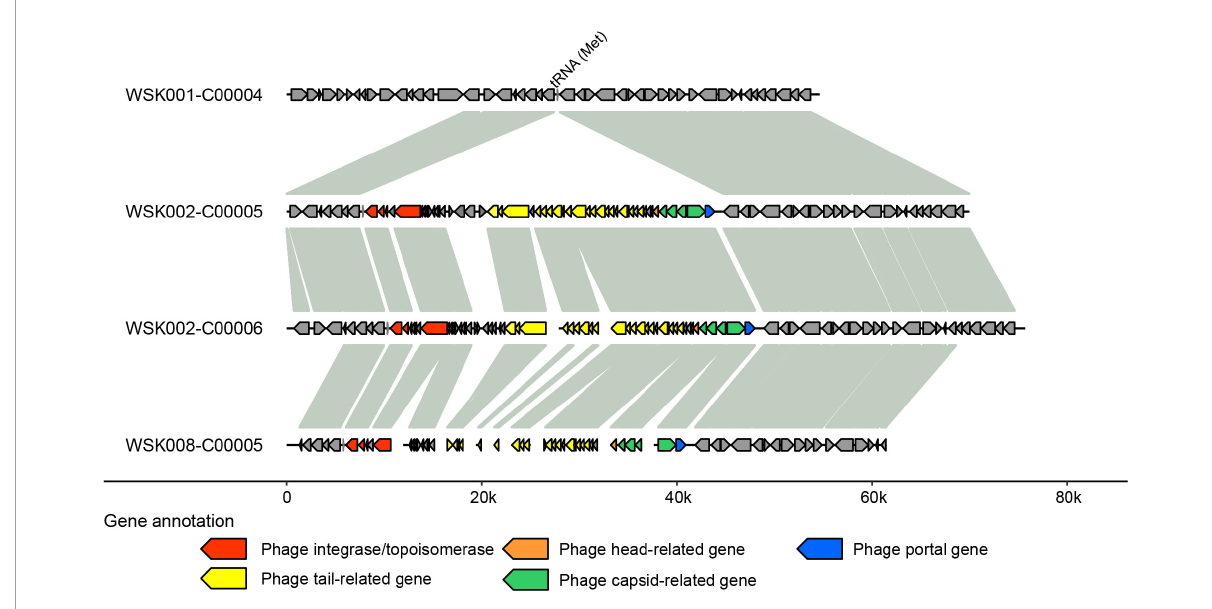
FIGURE6 Predicted prophage sequences in Moraxella osloensis high-quality single-amplified genomes (HQ SAGs) obtained from WSK002 and WSK008. The genes encoded here are shown in the gene occurrence pattern C in Figure 4A . The genome synteny was compared with the HQ SAG of